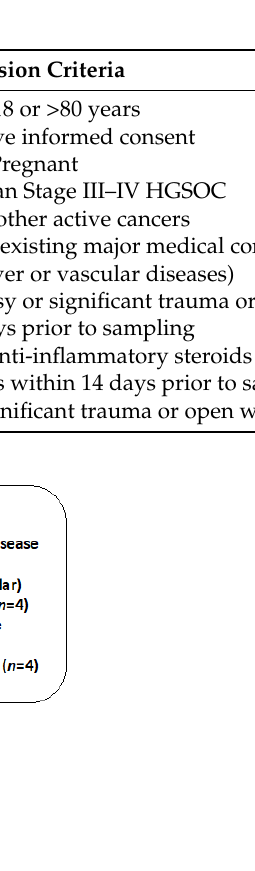
Table 1. Study inclusion and exclusion criteria.